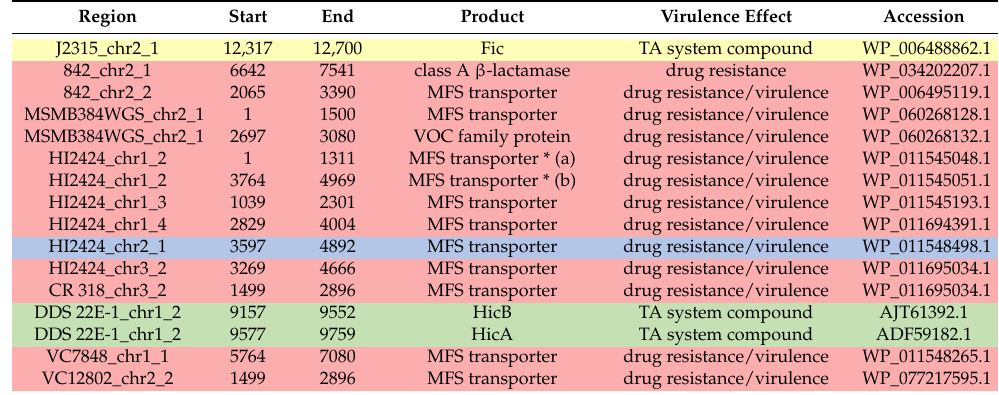
Table 4. Potential virulence factors located in found regions. Regions types were marked with colors: intact (green), questionable (blue), incomplete (red) and artifact region (yellow).